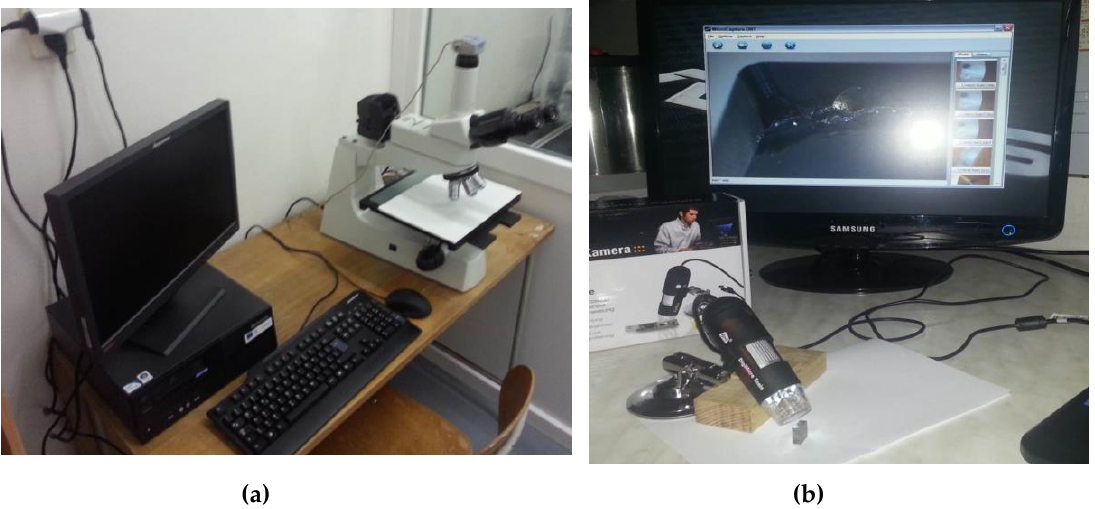
Table 2. C45—chemical composition.